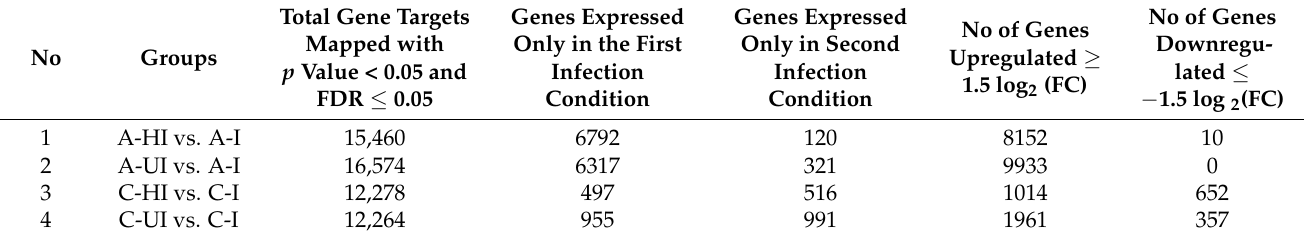
Table 2. Changes in expression of mRNA in T-cell